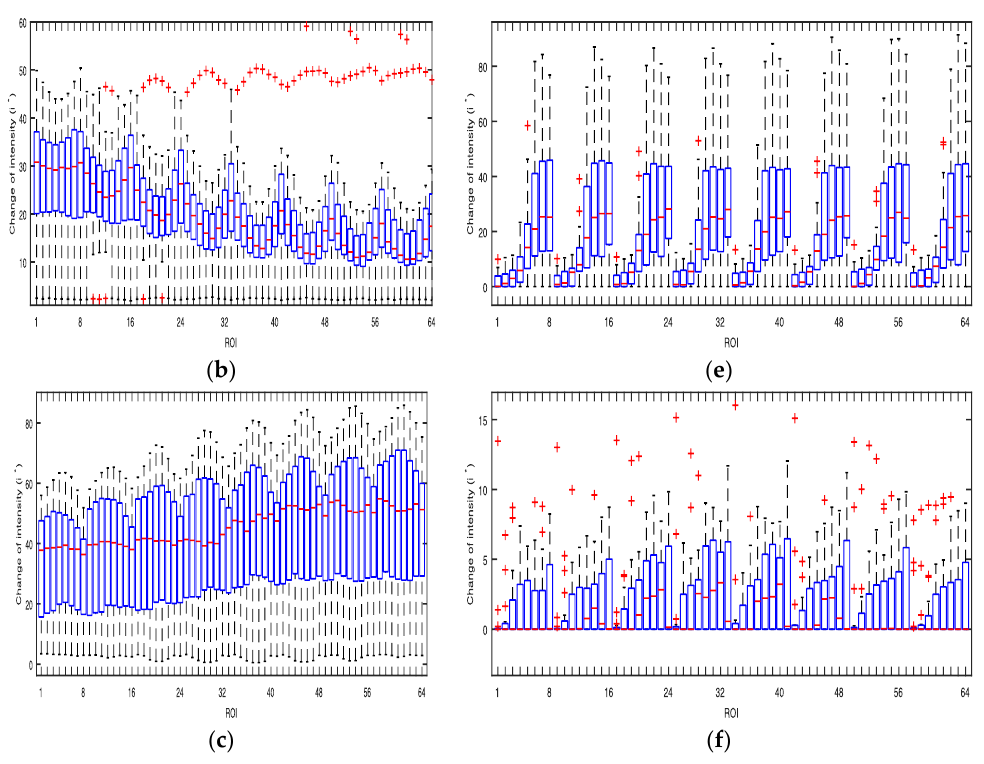
Figure 5. Box plot of the average values of 𝑖 ∗ of the three color bands obtained from the 64 ROIs of the Galaxy S6 and the Galaxy Note 3 from 30 subjects when the flashlight was on: ( a ) Red (Galaxy S6); ( b ) Green (Galaxy Note 3); ( c ) Blue (Galaxy Note 3); ( d ) Red (Galaxy Note 3); ( e ) Green (Galaxy Note 3); ( f ) Blue (Galaxy Note 3). Table 2. The average values of 𝑖 ∗ of the three color bands obtained from 64 ROIs when the flashlight was on.